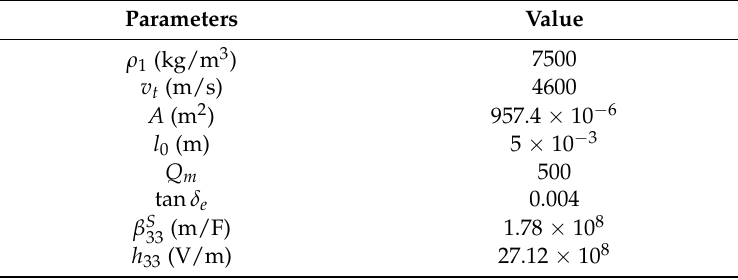
Table 1. The material parameters of the piezoelectric ceramic PZT-4.